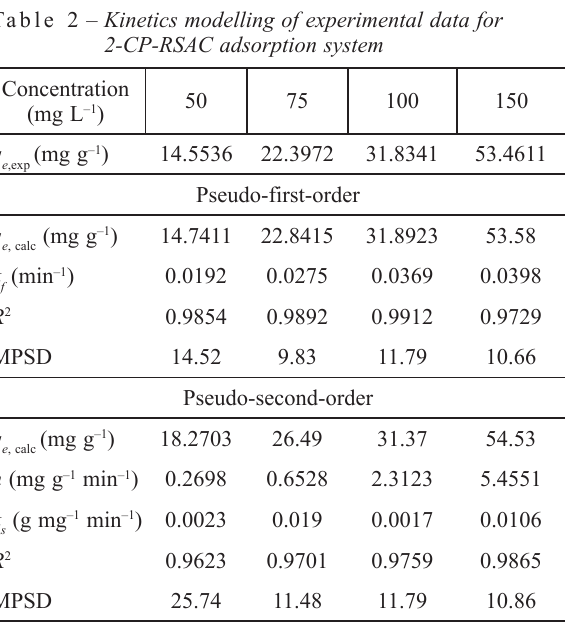
Table 2 – Kinetics modelling of experimental data for 2-CP-RSAC adsorption system Concentration (mg L –1 )